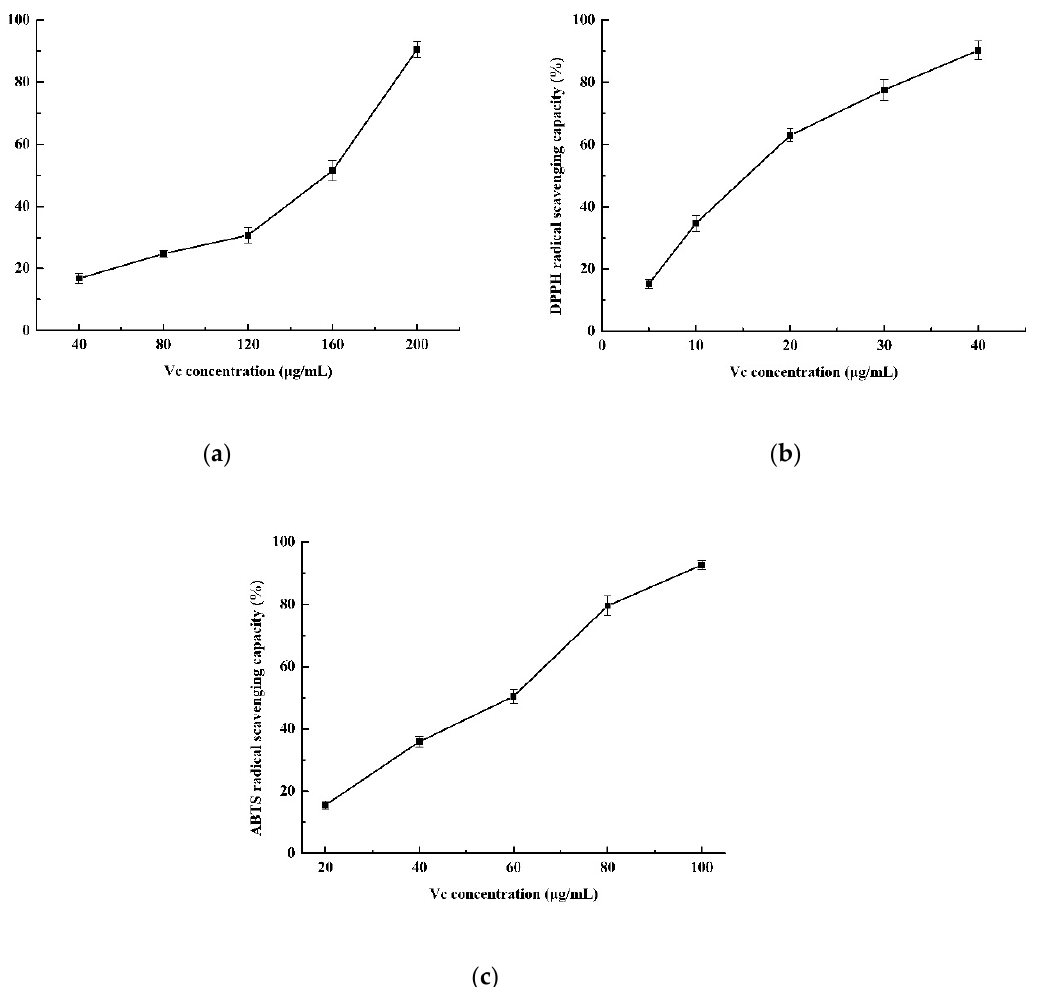
Figure 3. The FRAR ( a ), DPPH( b ), ABTS ( c ) radical scavenging capacity of the positive control (ascorbic acid) assay. acid)